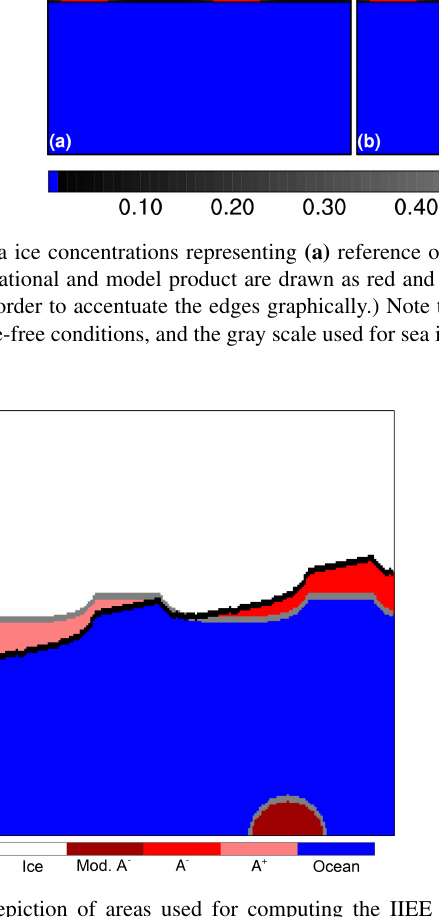
Figure 4. Depiction of areas used for computing the IIEE met- rics. The pink region corresponds to the A + area given by Eq. (9), whereas the A − area given by Eq. (10) is in red. The additional A − area in the modified case is in dark red. Ice edges are displayed as gray lines (observations) and black lines (model results). (These lines are drawn with 3 times their actual thickness in order to accen- tuate the edges graphically.) Regions where all products are on the open ocean side of the ice edges are blue, while regions inside the ice edges in all products are